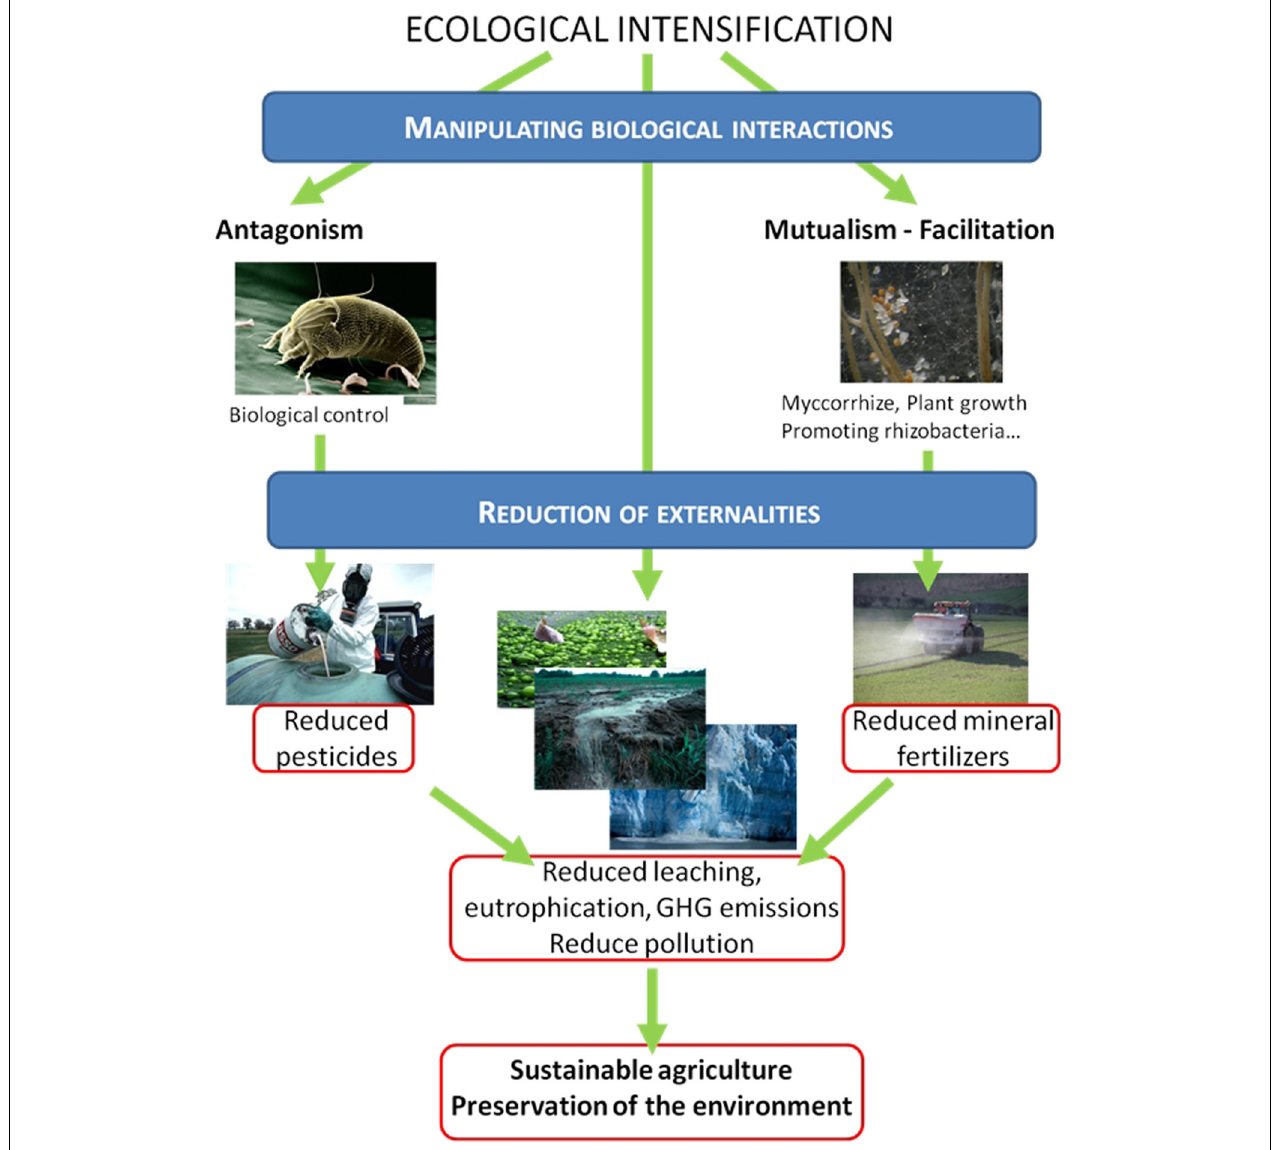
FIGURE 2 | Possible means (blue frames) and objectives (red frames) of ecological